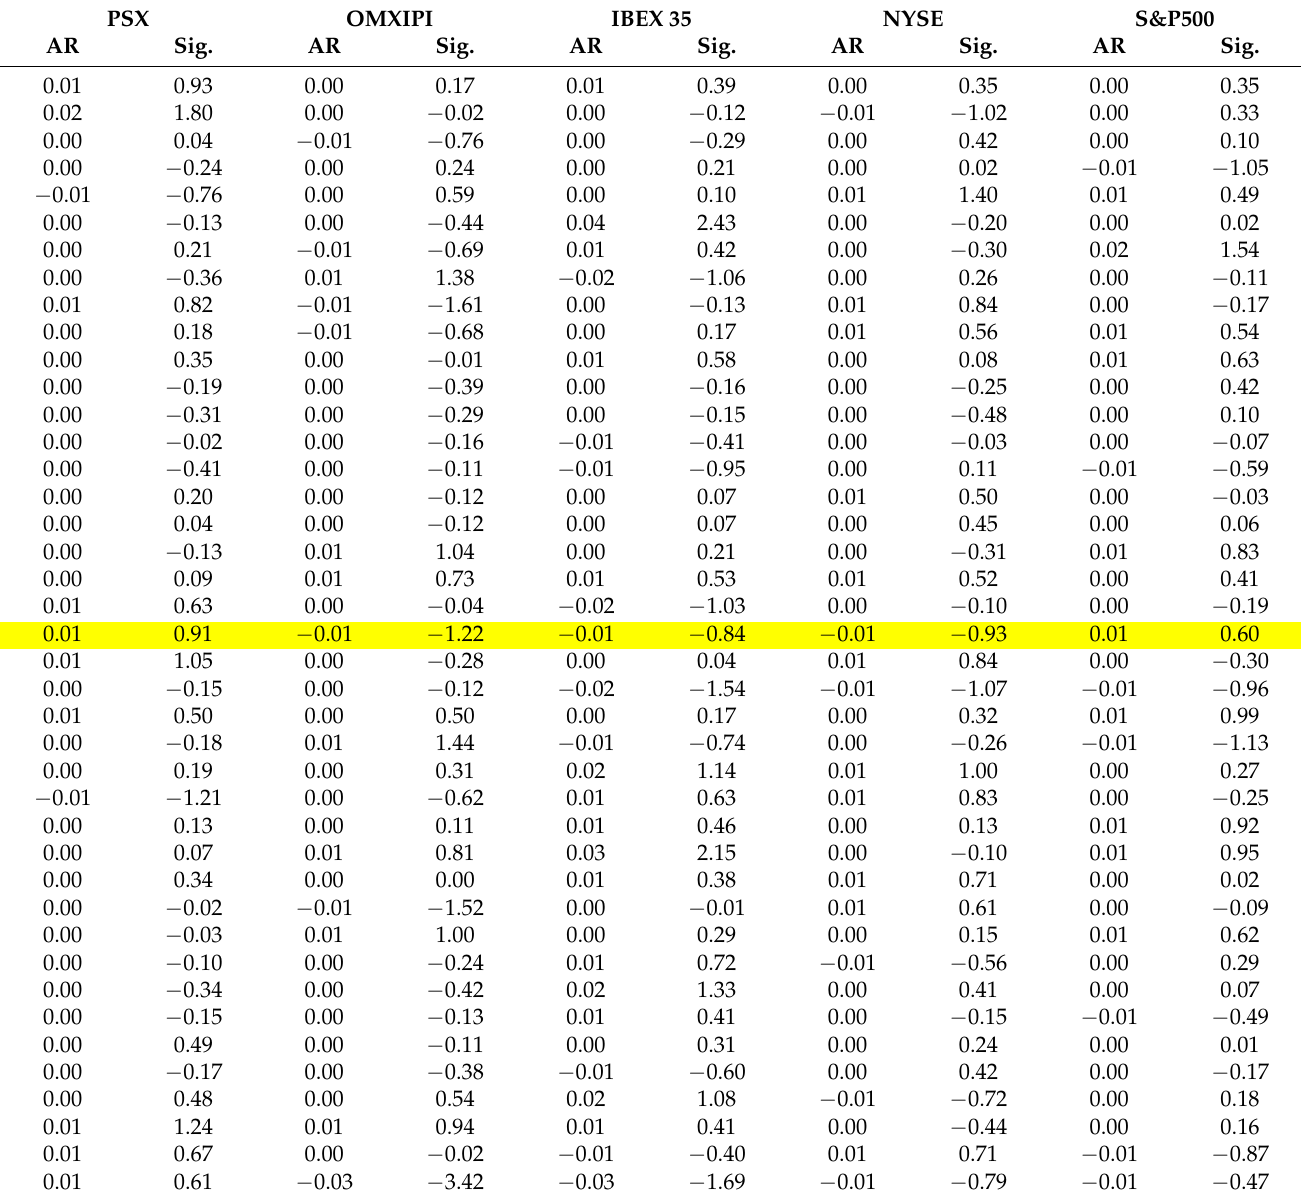
Table A1. Abnormal returns of the forty-day event window (News of Panama